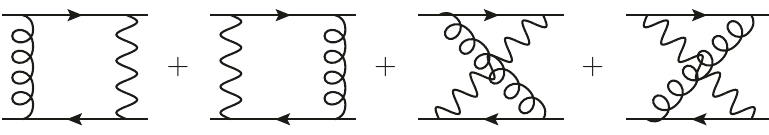
Figure 6 . Contributions to the 1 = q 2 potential at order (cid:11)